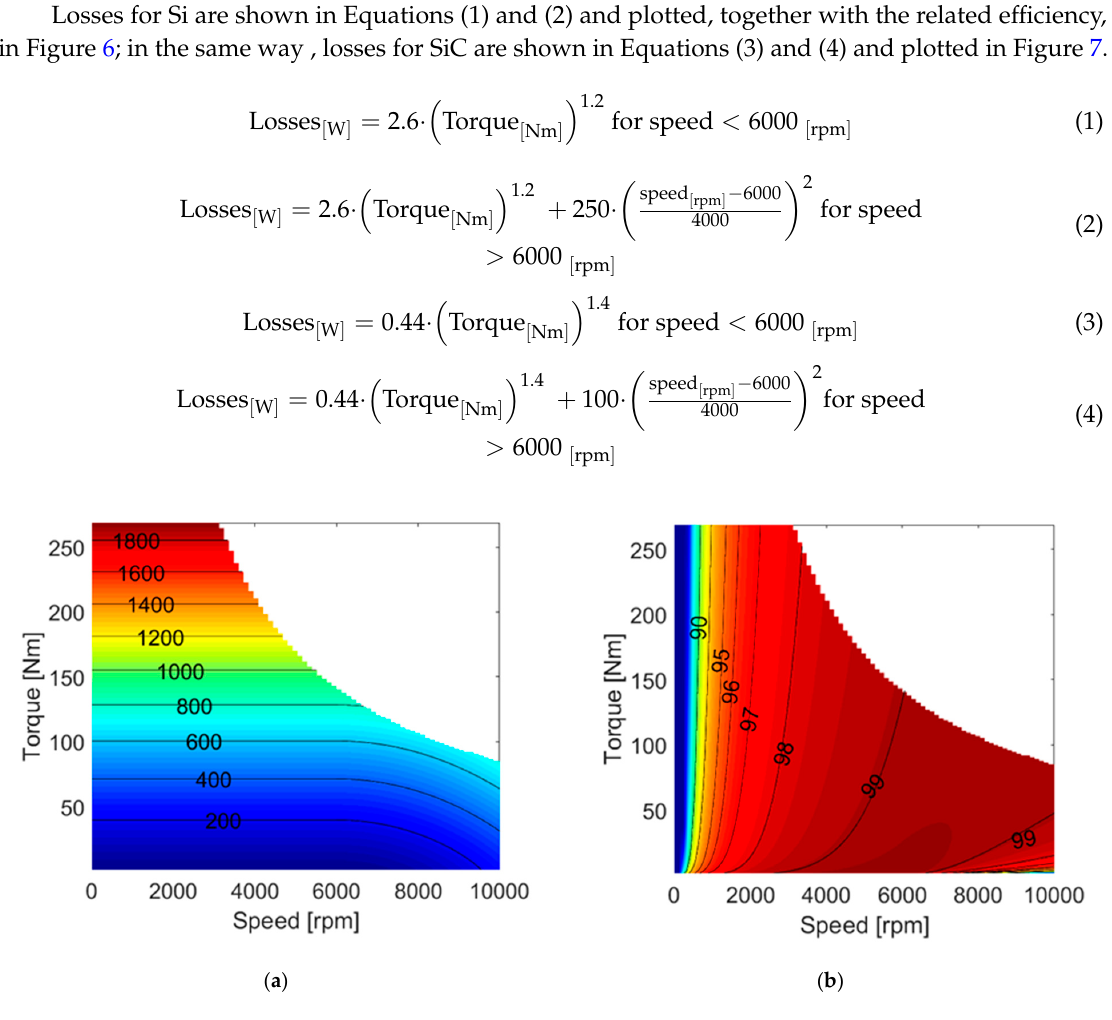
Figure 6. ( a ) Si inverter losses [W] and ( b ) efficiency [%].